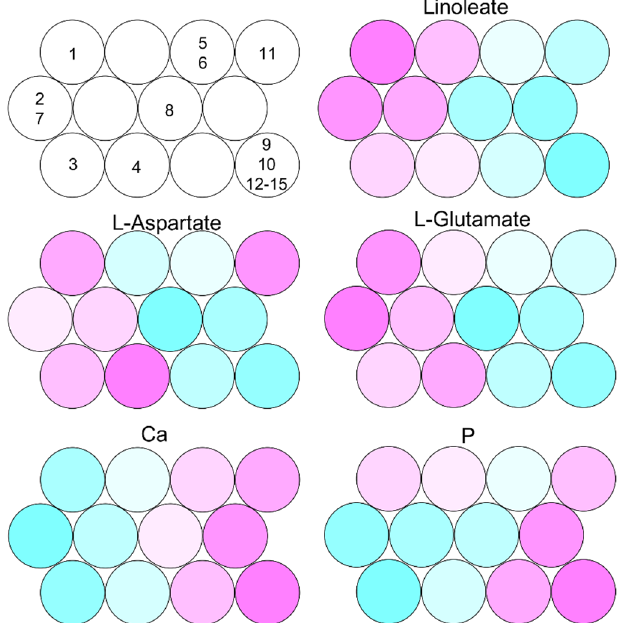
Figure 2. SOM visualization of fish meat and waste material profiles based on integrated data from NMR and ICP-OES: 1. escolar meat ; 2. oilfish meat; 3. red stingray meat; 4. left-eyed flounder